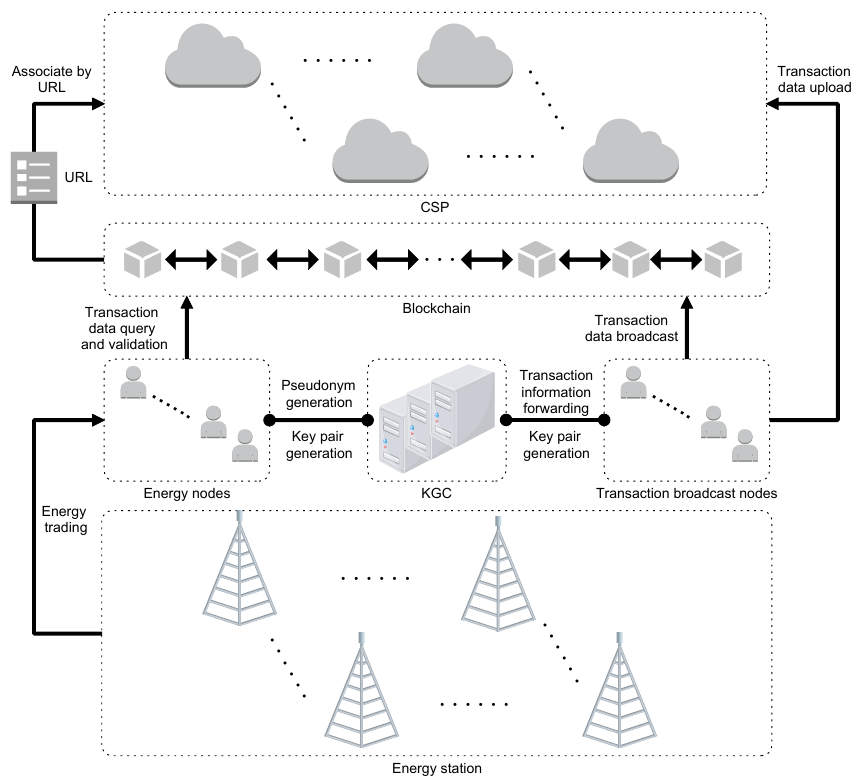
Figure 3. System